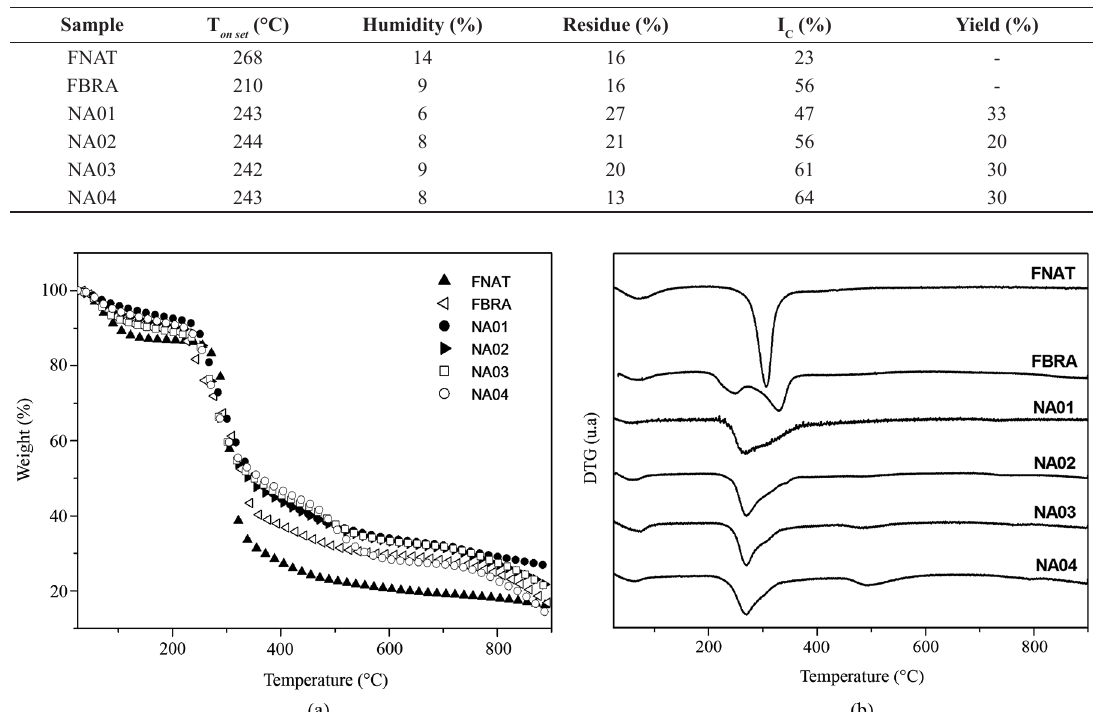
Table 2. Thermal analysis values.